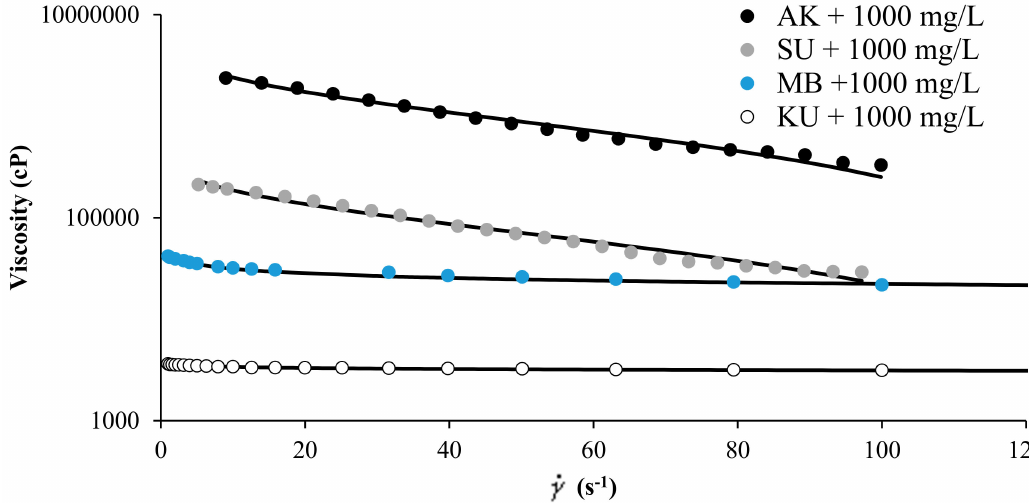
Figure 3. Viscosity of MB, SU, and KU heavy oils, and AK extra heavy oil in the presence of SiO 2 nanoparticles at 1000 mg/L and 298 K and shear rate between 0 and 120 s − 1